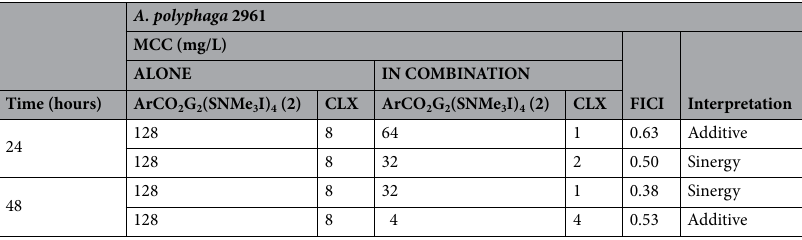
Table 7. FICI in cysts and its interpretation in A. polyphaga 2961 MCC (mg/L) for ArCO 2 G 2 (SNMe 3 I) 4 ( 2 ) and CLX alone or in combination after 24 and 48 h of treatment.